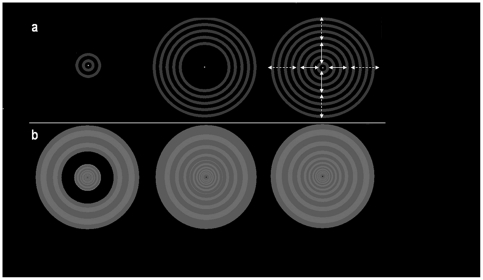
Visual stimuli.Panel a show static frames from the alternately expanding and contracting stimuli used in Experiment 1. Panel b shows the modified stimuli used in Experiment 2. Panel a (left) shows the central motion baseline, which was also used in both its moving and static form for defining the ROI. The central motion stimulus consisted of either 2 or 3 rings depending upon the stage of the expansion/contraction cycle. The static version consisted of a single frame from the moving version, chosen so that 3 rings were visible. Panel a (centre) shows the surround grating that was used in the definition of ROI for the purpose of excluding voxels exhibiting a direct response to peripheral motion. Panel a (right) shows how the two stimuli in Panel a were combined to produce a central motion area plus uniform or antiphase surround motion. The arrows indicate where the motion direction switched in the antiphase stimulus. Panel b presents examples of the “M scaled” stimuli used in Experiment 2. Panel b (left) shows the central motion area, as well as the dimensions of the gap and surround (where present). Panel b (middle) shows uniform surround motion with a thin static boundary imposed between the central 3 deg and the surround. For comparison, panel b (right) shows the uniform surround condition without the imposed boundary.